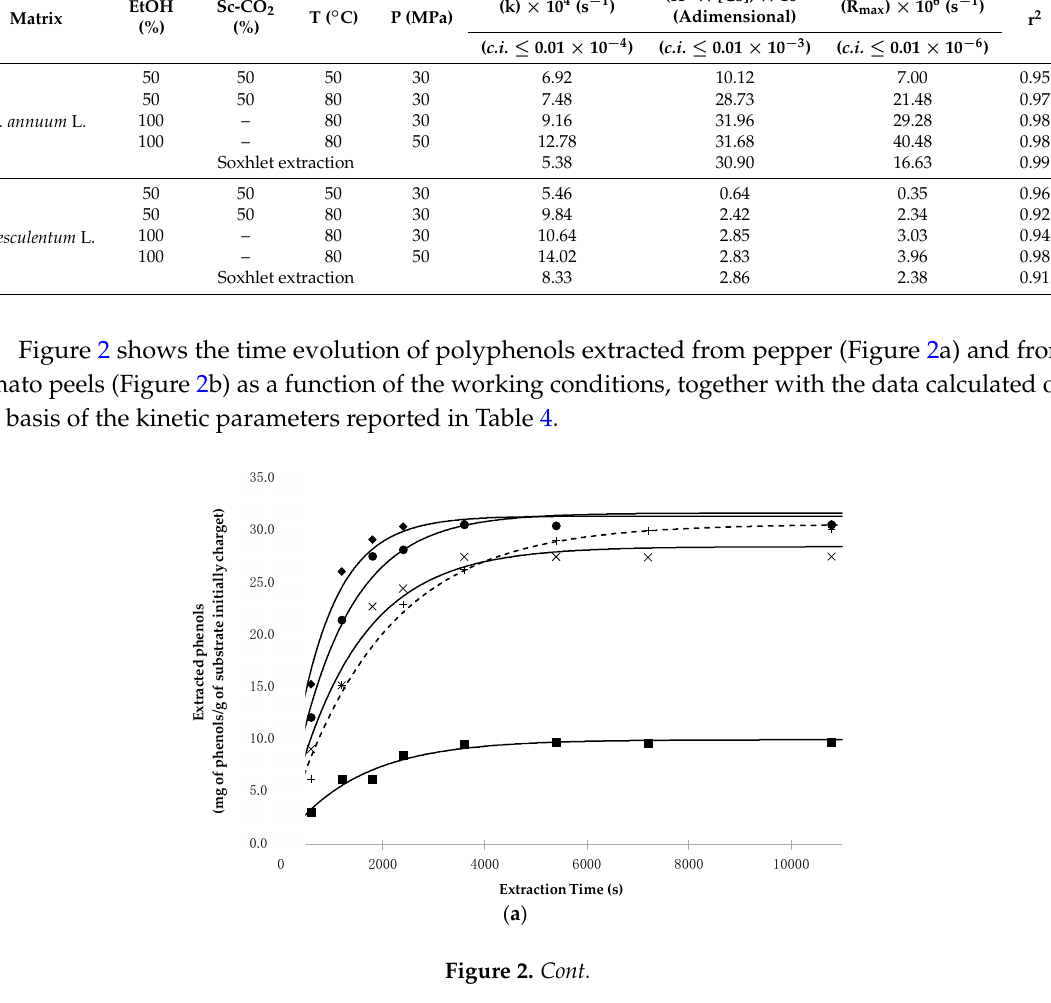
Table 4. Extraction of polyphenols from pepper and tomato by-products. Values assumed by R (cid:48) max and the equation parameters k (cid:48) and H (cid:48) * × [Ps] as a function of the working conditions. T = temperature; P = pressure; r = correlation coefficient.